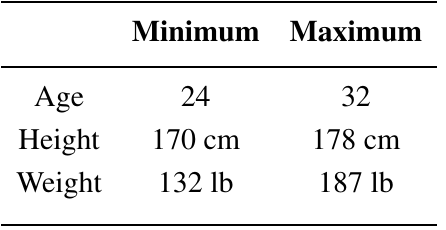
Table 1. Participants of data set.